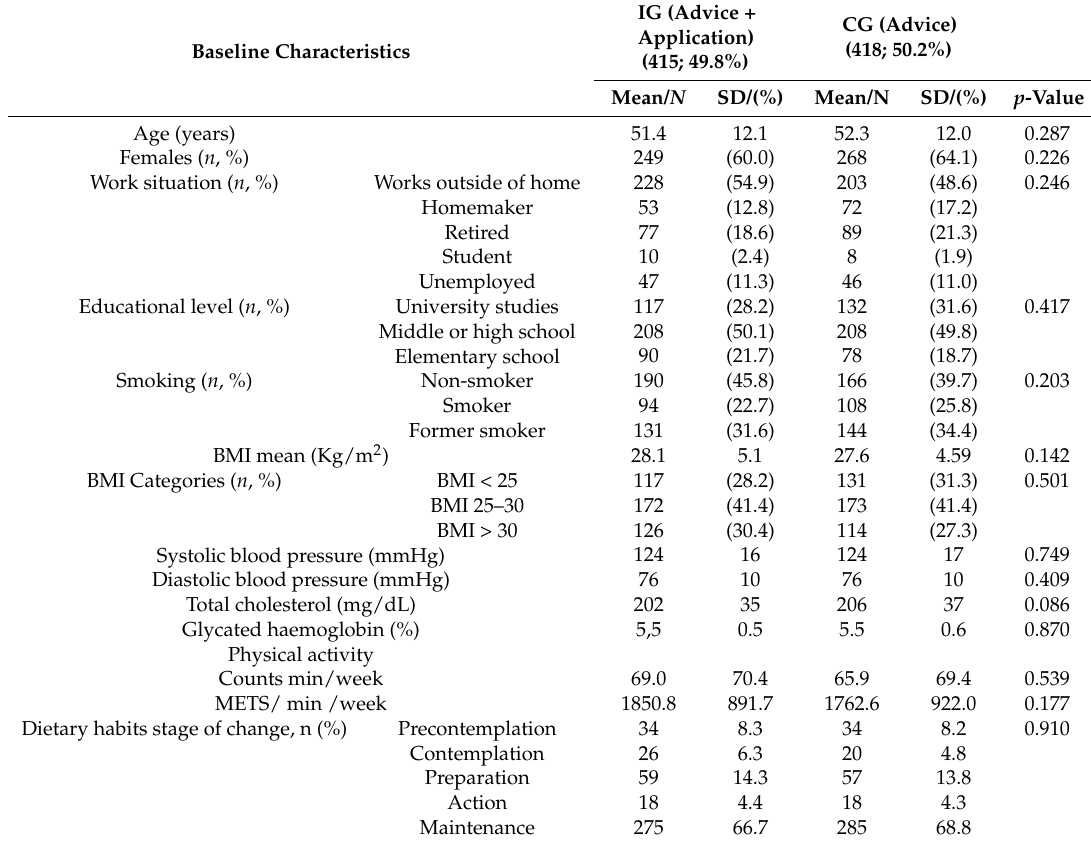
Table 1. Baseline characteristics of the study